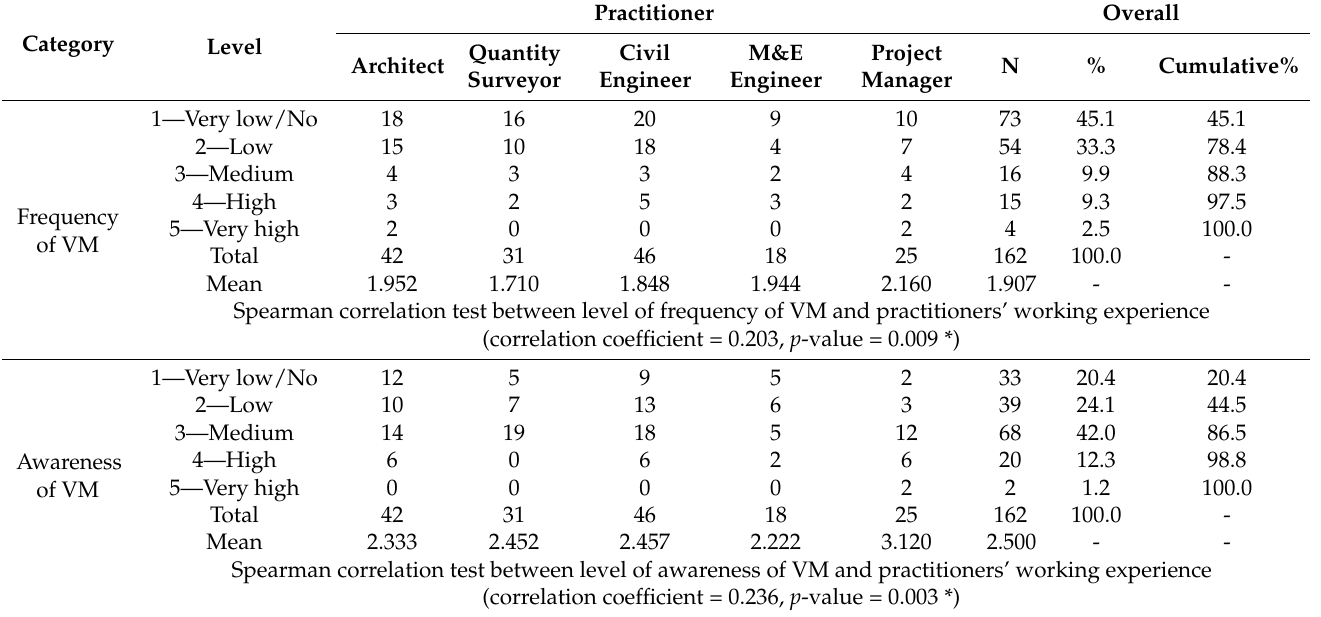
Table 3. Status of VM implementation: practitioner